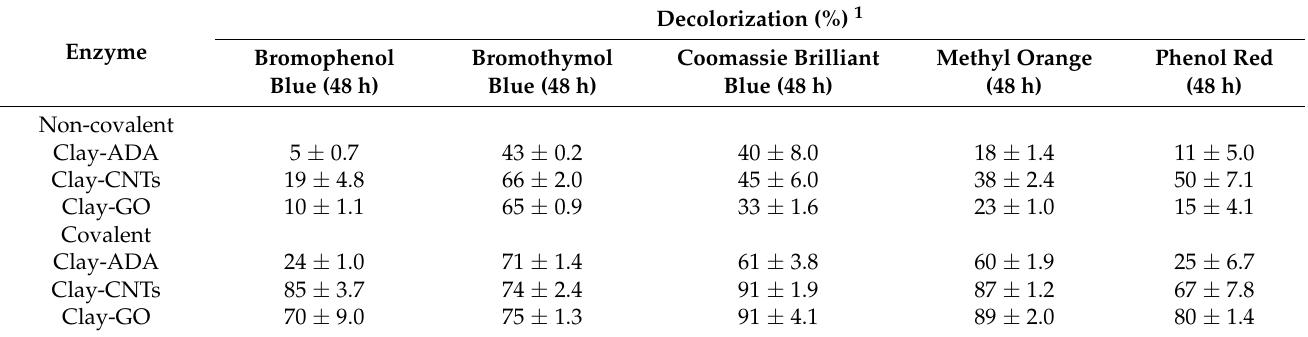
Table 4. Decolorization of different dyes by immobilized TvL on hybrid nanomaterials.